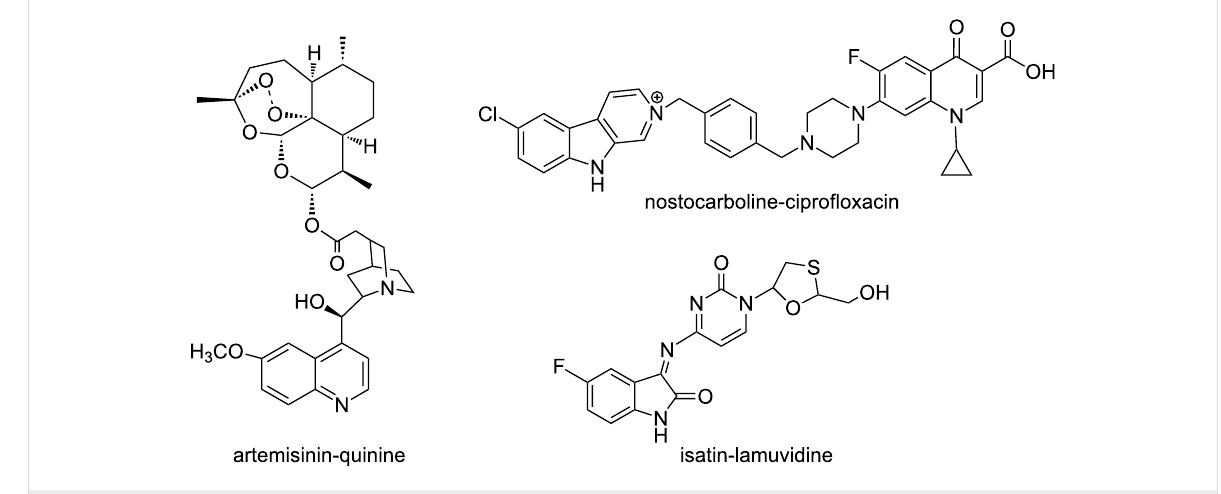
Figure 1: Natural product and natural product-like hybrids.